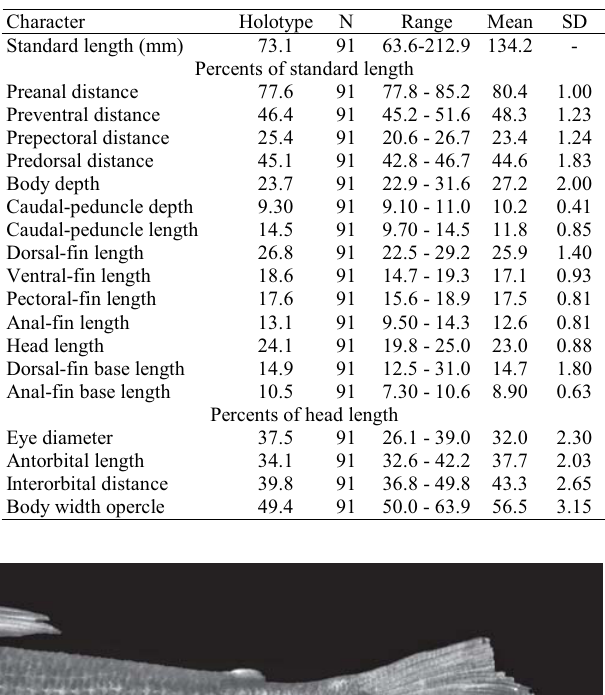
Table 3. Morphometrics of Laemolyta garmani.